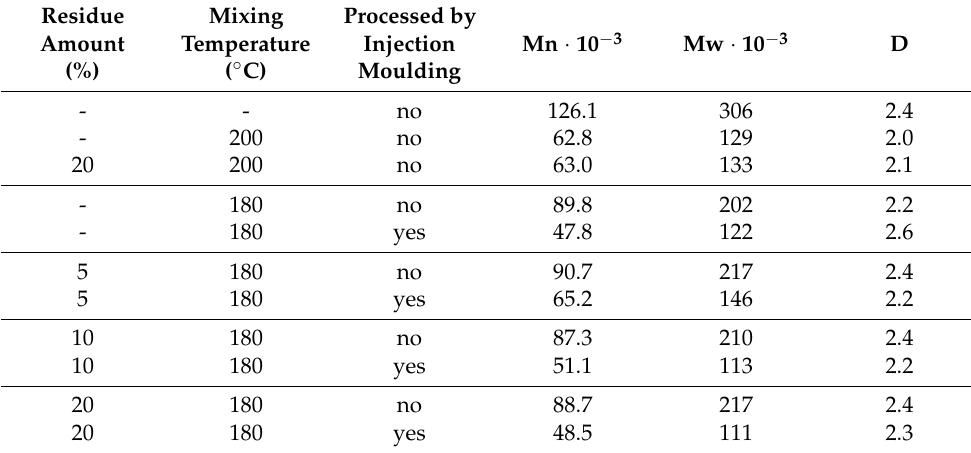
Table 3. Gel permeation chromatography (GPC) results for different poly(3-hydroxybutyrate-co-3- hydroxyvalerate) (PHBV)